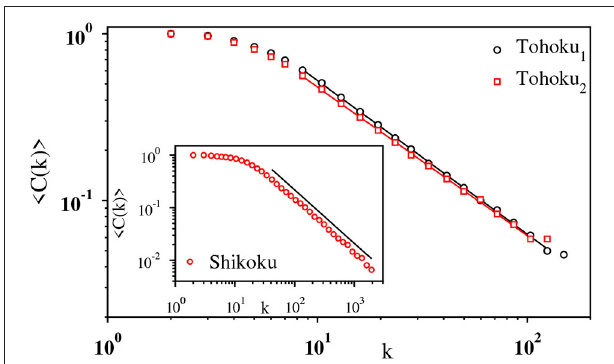
FIGURE 12 | The hierarchical nature of the visibility graph. The clustering C ( k ) coefficient has been plotted with k on a log-log scale for the Tohoku 1 h i (black) and Tohoku 2 (red) magnitude time series (main panel), and for the IET series of Shikoku (inset). The slopes of the fitted lines have been measured as 0.92(3), 0.89(3), and 1.01(2),